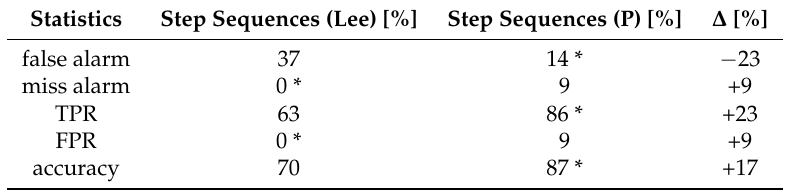
Table 6. Results of binary classification on step sequence, with respect to the statistical parameters (false alarm, miss alarm, TPR, FPR, and accuracy) for the two approaches: Lee (Lee) and proposed (P), at different speeds. The best values for each row are highlighted with the symbol *. The ∆ value represents the difference of each statistical parameter between the two methods